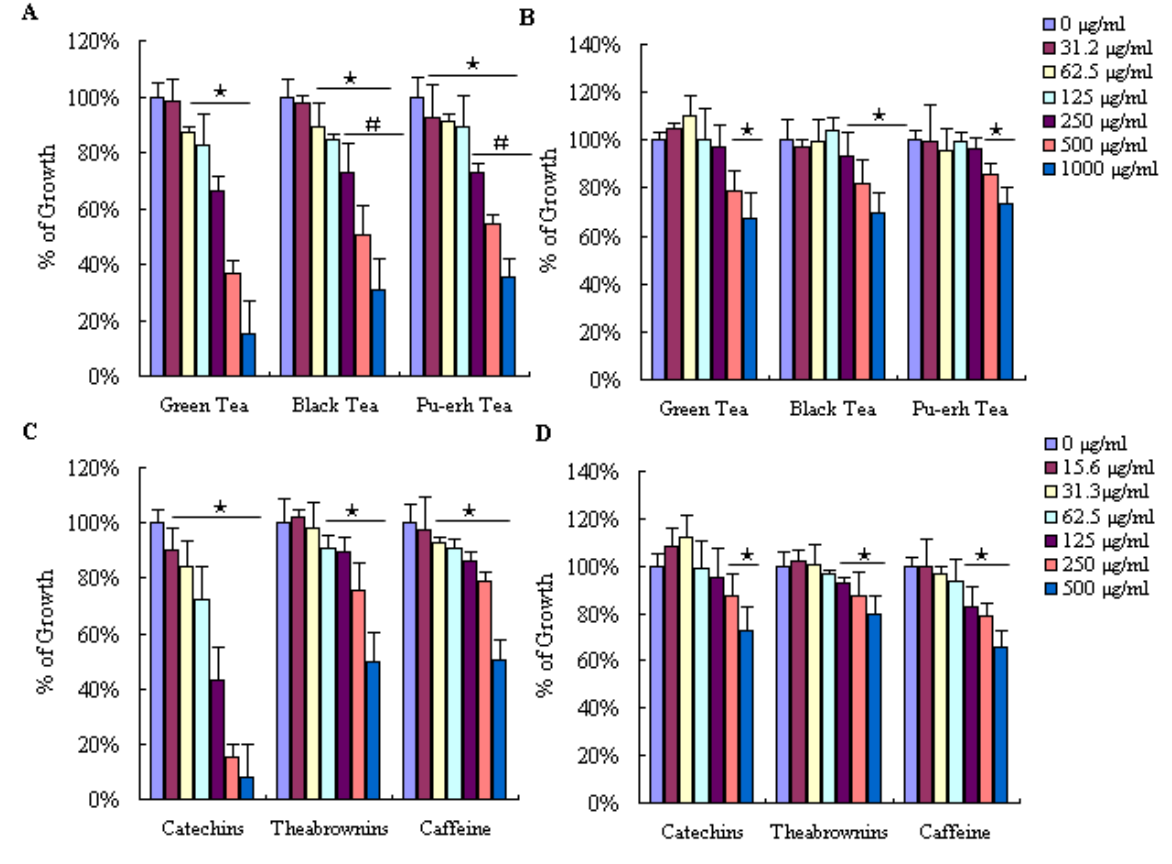
Figure 2. Proliferation of SGC-7901 and CCC-HEL-1 cells exposed to various drugs for 48 h by MTT assay. The proliferation rates of ( A ) SGC-7901 and ( B ) CCC-HEL-1 cells treated with three tea extract at the concentrations of 31.2–1000 μ g/mL. The proliferation rates of ( C ) SGC-7901 and ( D ) CCC-HEL-1